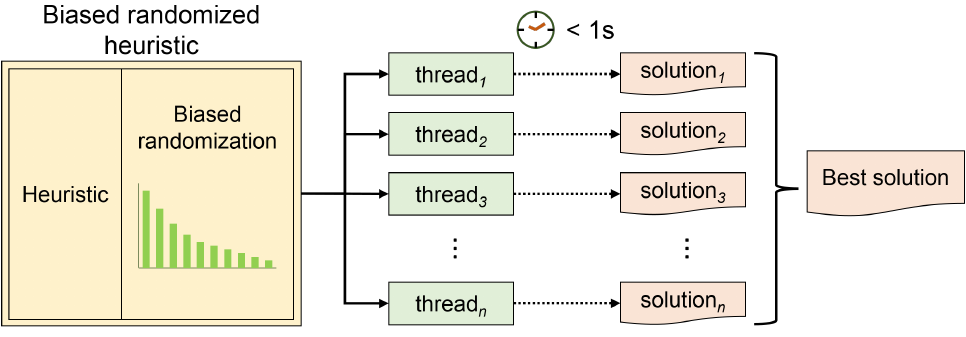
Figure 8. Schematic illustration of an agile algorithm.